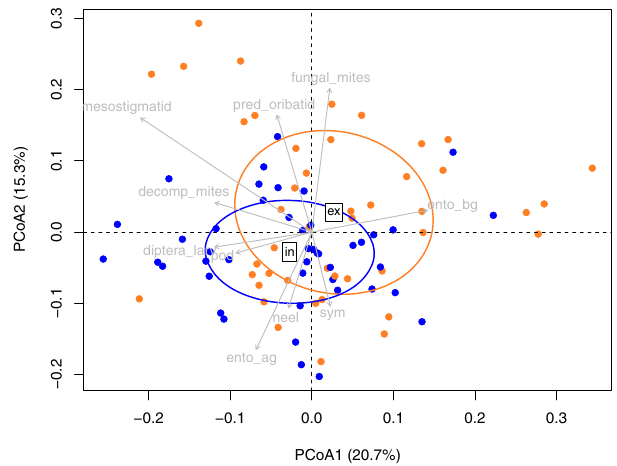
Fig. 3 | Grassland management impact on soil food web. Principal coordinates analysis (PCoA) of soil food web communities from grasslands with different land management (extensive in orange, intensive in blue) from the control plots at 5 sampling date ( n =90). The PCoA was based on Bray – Curtis distance using soil mesofauna abundances (individuals m − 2 ) and PLFA biomass (g m − 2 ). Grey arrows show the correlation vectors of the variables with the ordination. Signi fi cance was testedbyMonteCarlopermutationagainst999randomdatasetsandvariableswith P >0.05 were kept (see Supplementary Table 2). Ento_ag epigeic entomo- bryomorpha, ento_bg eudaphic entomorbyomorpha, pod poduromorpha, sym symphypleona, neel neelipleona, decomp_mites decomposer mites, fungal_mites fungivorous mites, pred_oribatids predatory oribatids, pred_col_ad predatory coleoptera, pred_col_larv predatory coleoptera larvae, detrit_col_ad detritivorous coleoptera, detrit_col_larv detritivorous coleoptera larvae, diptera_larv diptera lar- vae, bactplfa bacterial PLFA, fungplfa fungal PLFA, amfplfa AM fungal PLFA, acti- noplfa actinobacteria